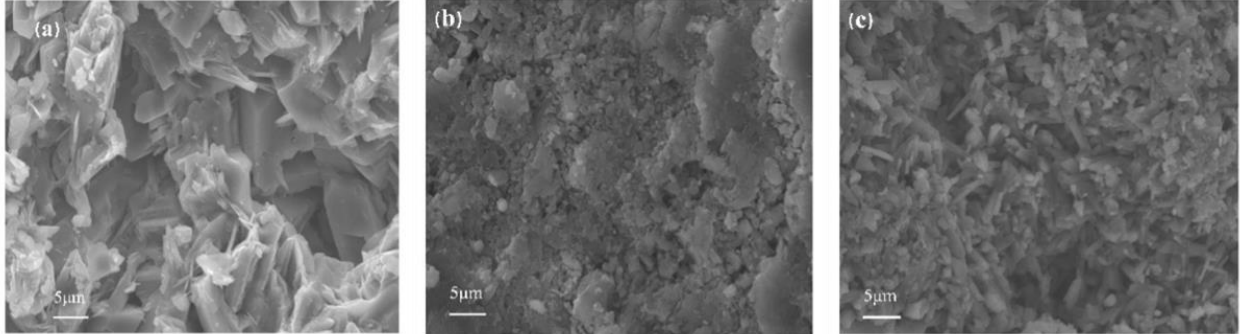
Figure 11. SEM images of gypsum ( a ) 0%, ( b ): 1% Nano-SiO 2 , ( c ): 1% NCC (multiple = 2.7 k, scale = 5.00 μm) .